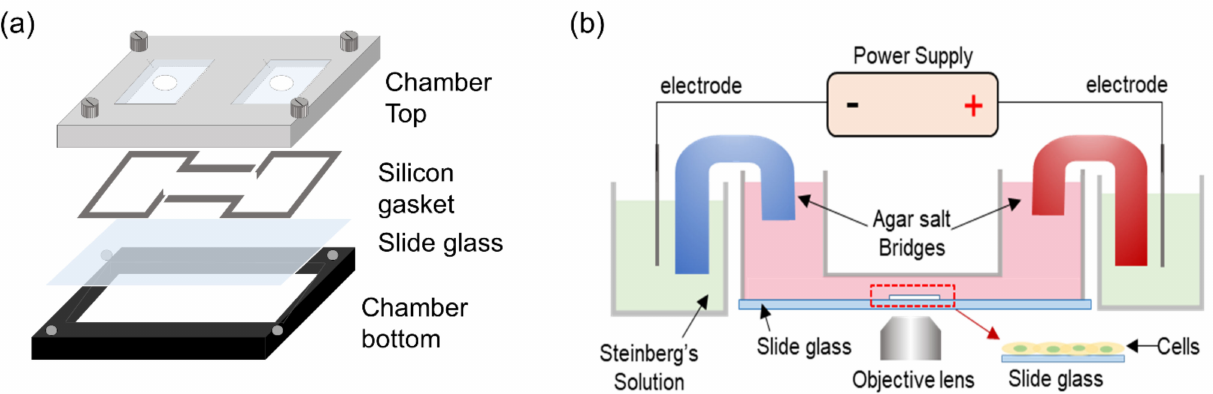
Figure 1. Schematic illustration of the customized agar-salt electrotaxis chamber and system. ( a ) Deconstructed view of electrotaxis chamber used for real-time observation of migration of cells cultured on a glass slide. ( b ) The chamber was installed on the incubator system, which consisted of a CO 2 and temperature-controlled chamber with reservoirs connected to the wells at each end of the chamber via 2% agar-salt bridges. Electrical stimulation was applied through platinum electrodes immersed in Steinberg’s solution contained in the reservoirs. Cell behavior was observed using an inverted microscope and recorded using a CCD camera connected to a personal